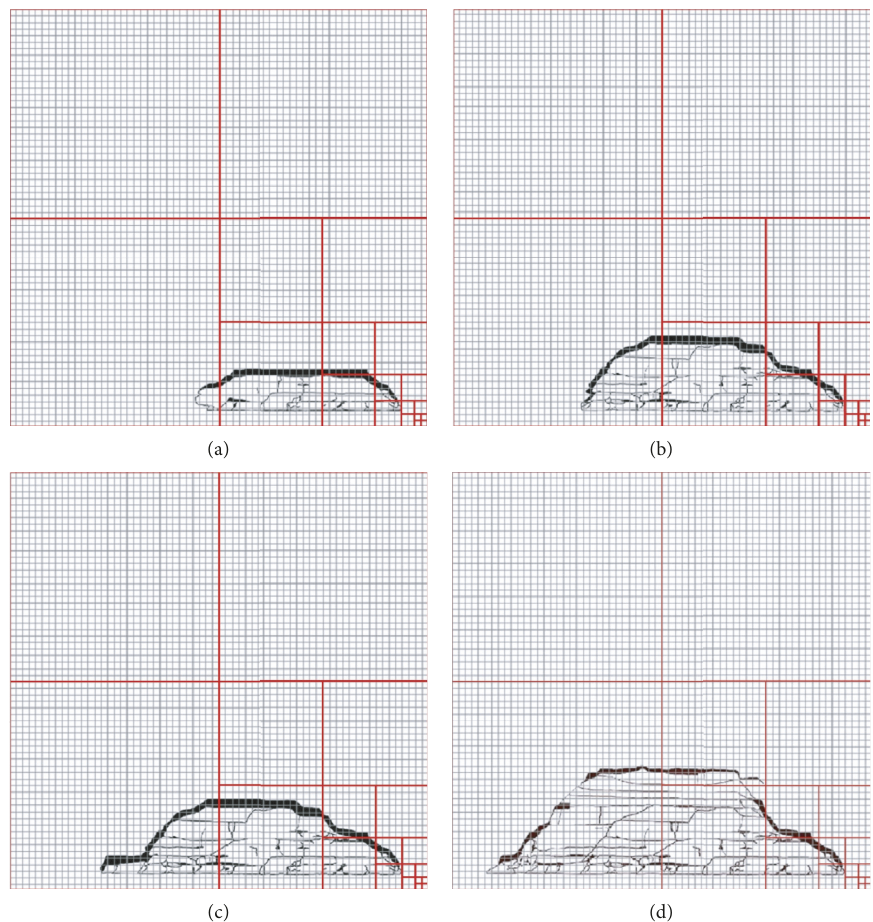
Figure 4: Schematic diagram for the “counting the boxes” method. Mining face 5-1 at a mining length of (a) 1200mm; (b) 1500mm; (c) 1800mm; (d)